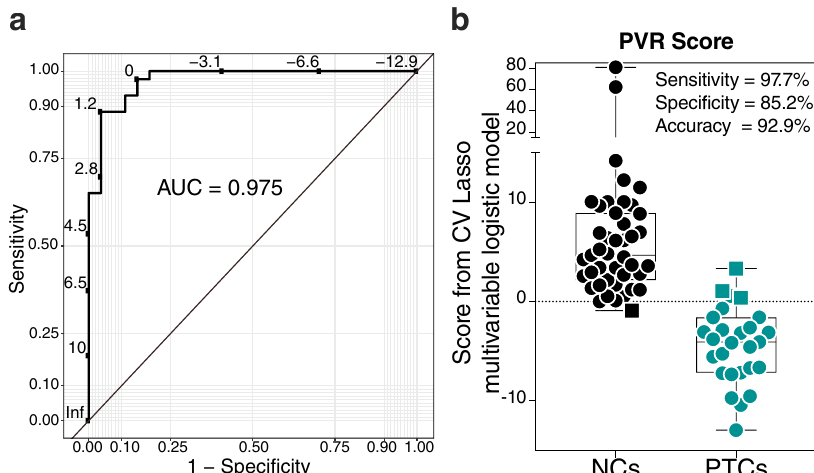
Fig. 7 A multivariable logistic model using Lasso selected variables predicts the probability of viral remission post-ATI. The machine-learning algorithm, Lasso regularization, selected seven markers from the ten markers in Fig. 6. Analysis using this model demonstrates that when these seven markers are combined, their predictive ability is better than the predictive ability of any marker individually (Supplementary Table 9). a Receiver operator characteristic (ROC) curve showing the area under the curve (AUC) is 97.5% from the multivariable logistic regression model with seven variables. n = 70 biologically independent samples. b Coef fi cients from the multivariable logistic model were used to estimate risk score for each individual and then tested for the ability of these scores to accurately classify post-treatment controllers (PTCs) and non-controllers (NCs) at an optimal cut-point. The model correctly classi fi ed 97.7 of NCs (sensitivity), 85.2% of PTCs (speci fi city) with an overall accuracy of 92.9%. Squares represent individuals the model failed to identify correctly. The center of the box showing median with the whiskers going from each quartile (25th and 75th percentiles) to the minimum and maximum, respectively. n = 70 biologically independent samples. PVR probability of viral rebound score. Source data are provided as a Source Data fi